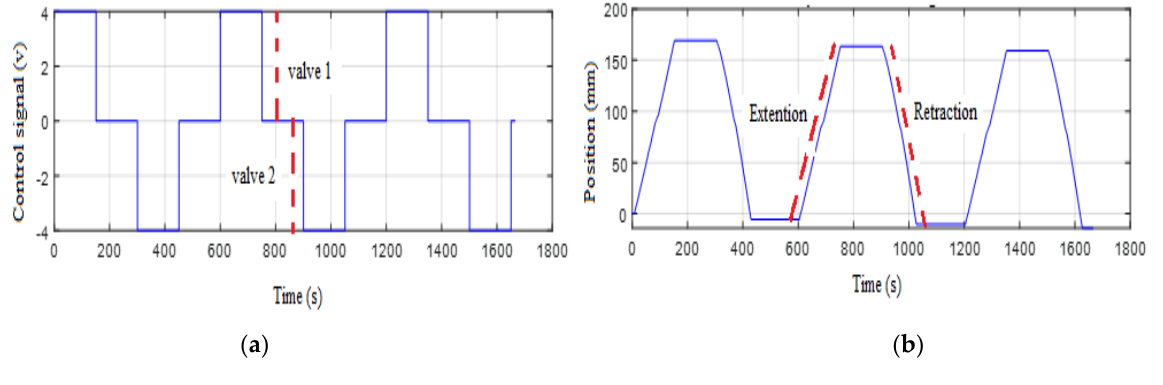
Figure 3. ( a ) input data and ( b ) output